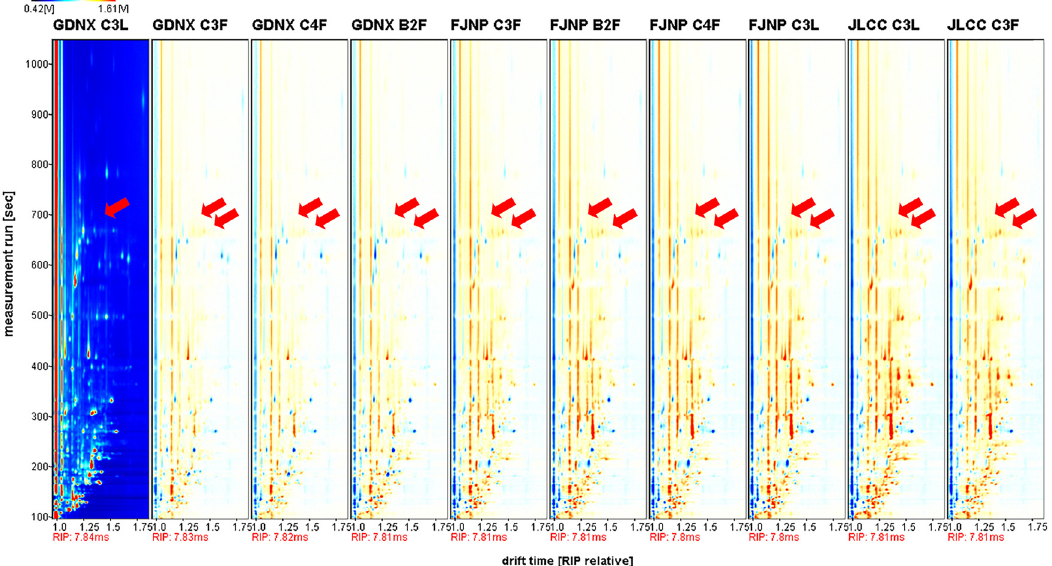
Figure 2: Di ff erence diagram of ion mobility spectrum of tobacco samples.